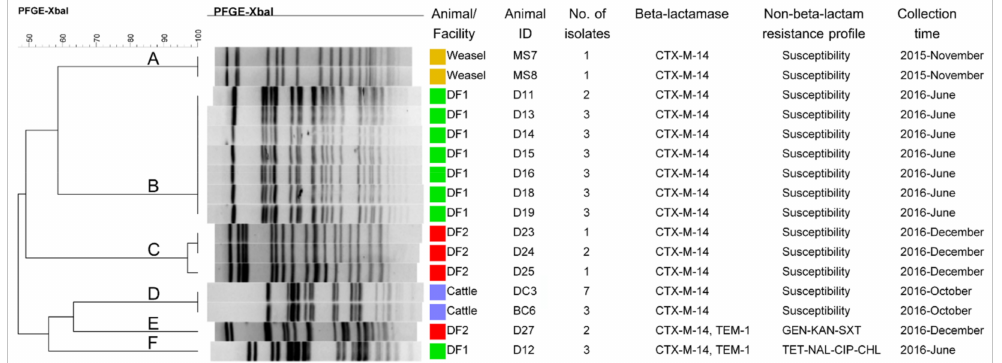
Figure 2. The CTX-M-14-producing E. coli isolates from 14 CTX-M-14-producing E. coli -positive samples collected from three domestic animal facilities and wild weasels were classified into six clusters (cluster A, B, C, D, E, and F) and seven pulsed-field gel electrophoresis (PFGE) profiles (an unweighted pair group method with arithmetic mean (UPGMA) analysis: 1% optimization and 1% band-filter tolerance). BC, beef cow; CHL, chloramphenicol; CIP, ciprofloxacin; D, dog; DC, dairy cow; DF1, dog facility 1; DF2, dog facility 2; GEN, gentamycin; KAN, kanamycin; NAL, nalidixic acid; MS, Mustela sibirica (weasel); SXT, sulfamethoxazole/trimethoprim; TET,